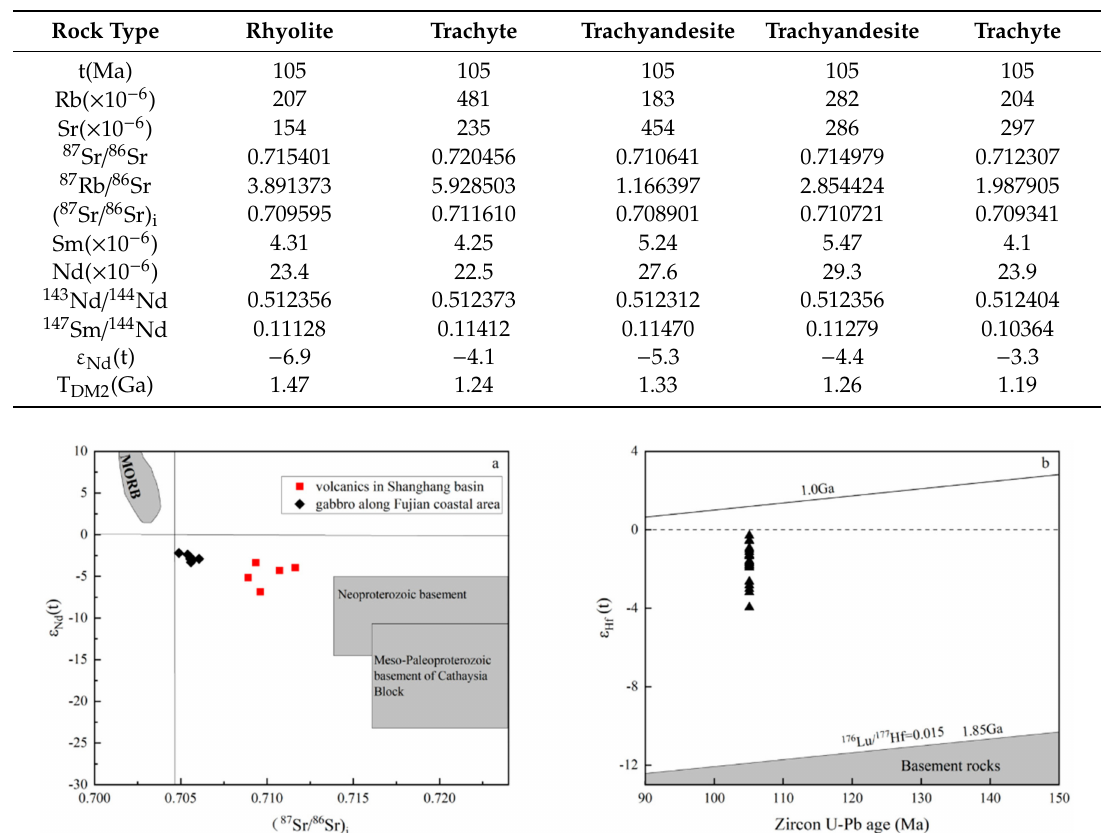
Table 1. Rb–Sr and Sm–Nd isotopic data for the volcanic rocks from the Zijinshan ore district.